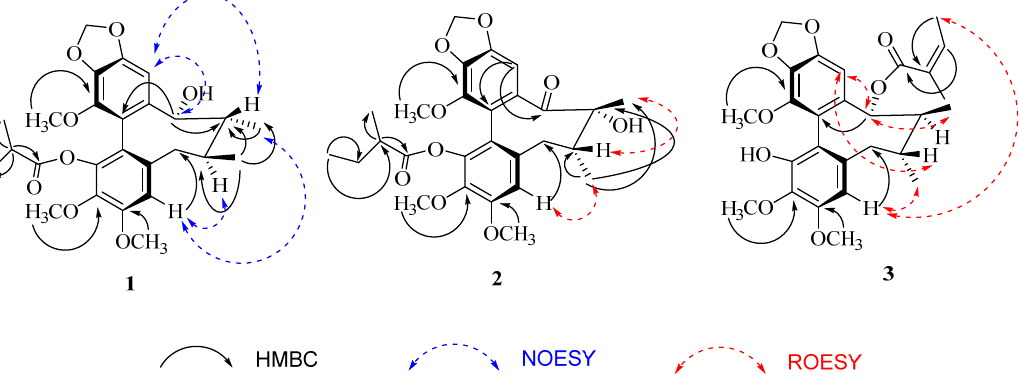
Figure 2. Key HMBC and NOESY correlations of heilaohulignan A ( 1 ) and ROESY correlations of heilaohulignans B–C ( 2 – 3 ).